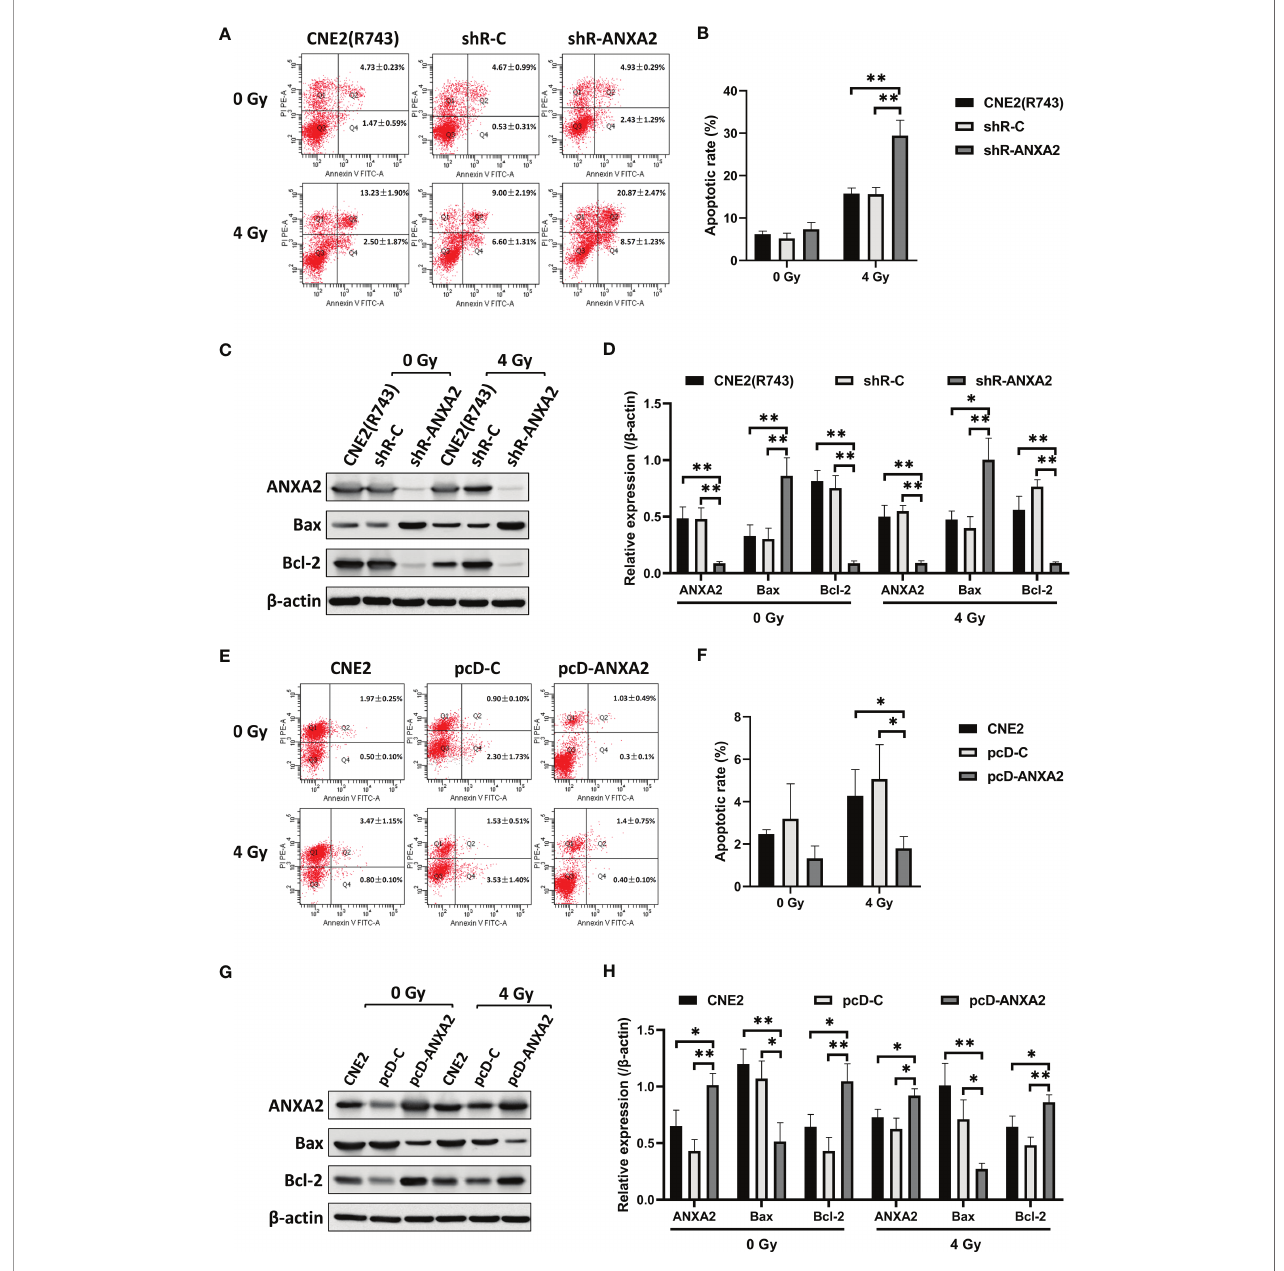
FIGURE 4 | ANXA2 knockdown increases irradiation-induced apoptosis and ANXA2 overexpression decreases irradiation-induced apoptosis in NPC cells. (A) fl ow cytometric analysis detects the apoptosis of shR-ANXA2, shR-C and CNE2(R743) cells 48 h post-exposure to irradiation at doses of 0 and 4 Gy; (B) a higher apoptotic rate is measured in shR-ANXA2 cells than in shRNA-C and CNE2(R743) cells 48 h post-exposure to irradiation at a dose of 4 Gy; (C) Western blotting determines the expression of apoptosis-related proteins in shR-ANXA2, shR-C and CNE2(R743) cells 48 h post-exposure to irradiation at doses of 0 and 4 Gy, and b -actin serves as a loading control; (D) higher Bax expression and lower Bcl-2 expression is determined in shR-ANXA2 cells than in shR-C and CNE2(R743) cells 48 h after 4 Gy irradiation; (E) fl ow cytometric analysis detects the apoptosis of pcD-ANXA2, pcD-C and CNE2 cells 48 h post-exposure to irradiation at doses of 0 and 4 Gy; (F) a lower apoptotic rate is detected in pcD-ANXA2 cells than in pcD-C and CNE2 cells; (G) Western blotting determines the expression of apoptosis-related proteins in pcD-ANXA2, pcD-C and CNE2 cells 48 h post-exposure to irradiation at doses of 0 and 4 Gy, and b -actin serves as a loading control; (H) lower Bax and higher Bcl-2 expression is determined in pcD-ANXA2 cells than in pcD-C and CNE2 cells. Data are presented as mean ± SD of three experiments. * P < 0.05, ** P <